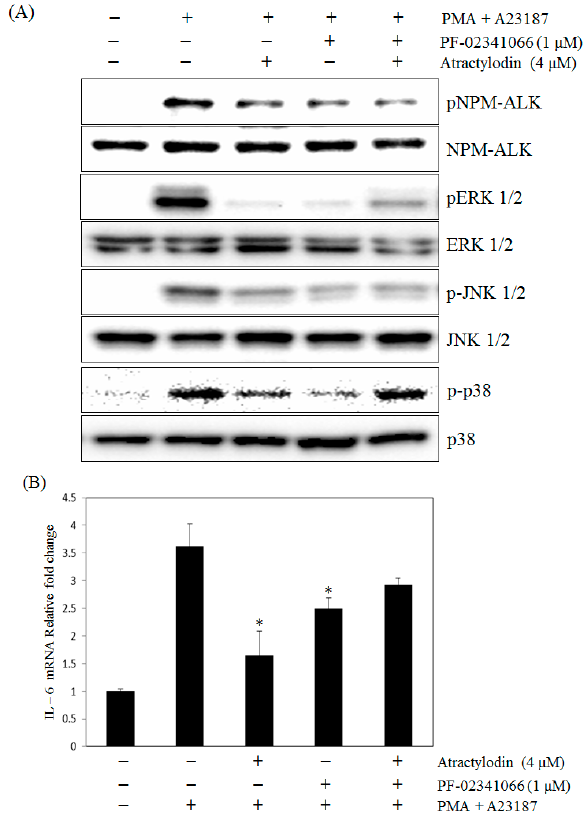
Figure 6. Effect of atractylodin and PF-02341066 on the phosphorylation of MAPKs ( A ) and the expression of IL-6 mRNA ( B ) in PMA plus A23187-stimulated HMC-1. ( A ) Cells were treated with or without atractylodin and PF-02341066 (1 μ M) for 0.5 h and then treated with PMA plus A23187 for 0.5 h. Whole cell lysates were then analyzed by Western blot; ( B ) Cell was treated with atractylodin for 0.5 h prior to being incubated with PMA (50 nM) plus A23187 (1 μ M) for 24 h and detected by real-time RT-PCR analysis as described in Materials and Methods. Statistical significance: * p < 0.05 as compared to the PMA plus A23187 treated group.